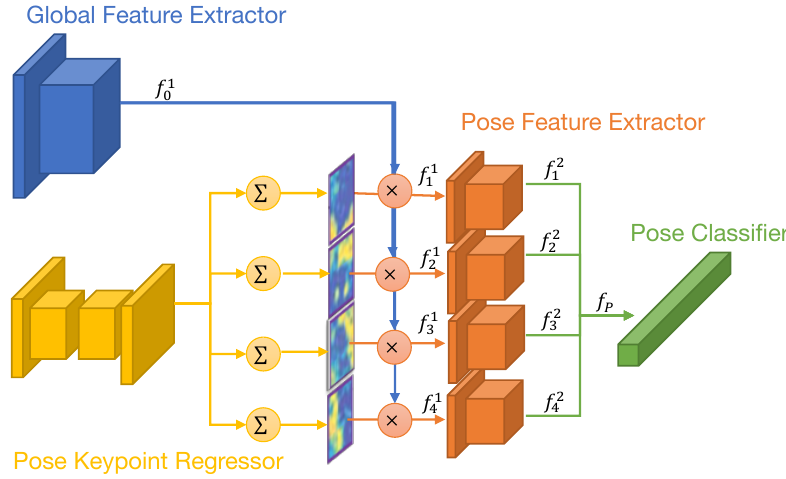
Figure 5. Illustrates the network architecture of the KPC